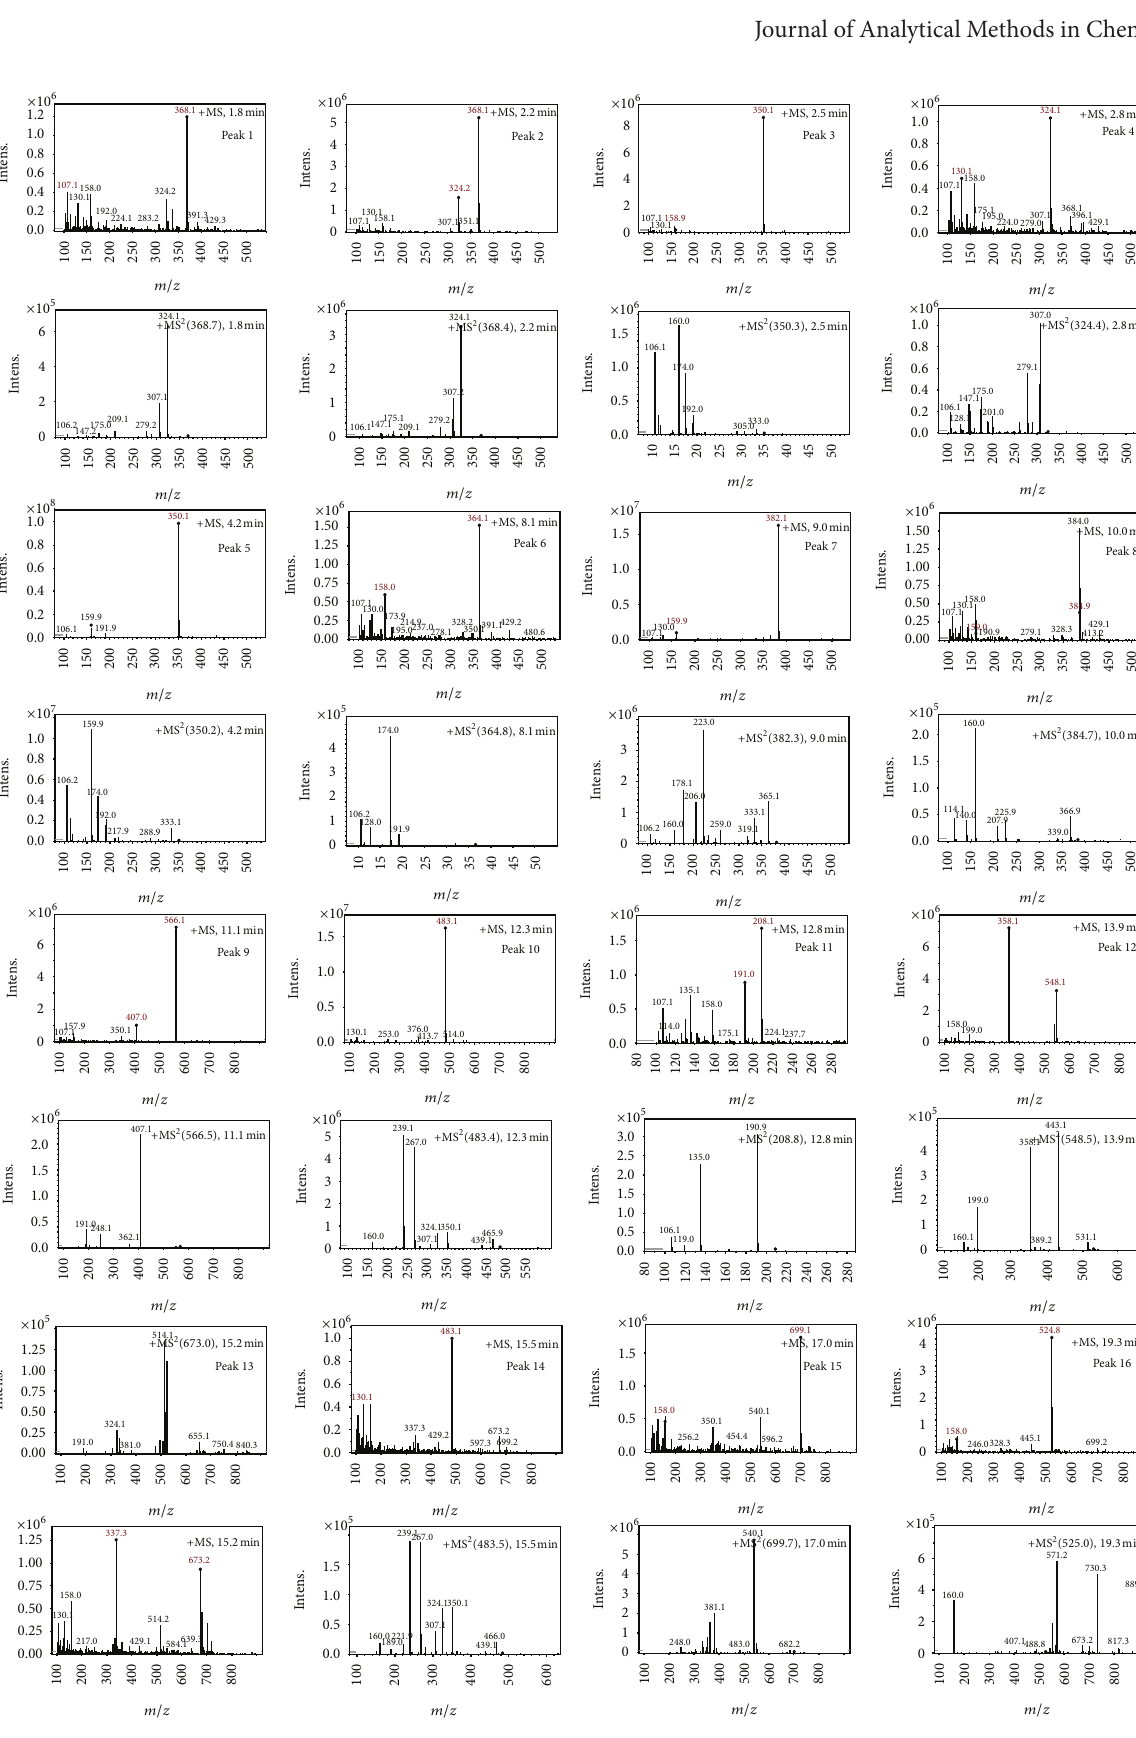
Figure 2: The mass spectrum of 16 chemicals in ampicillin